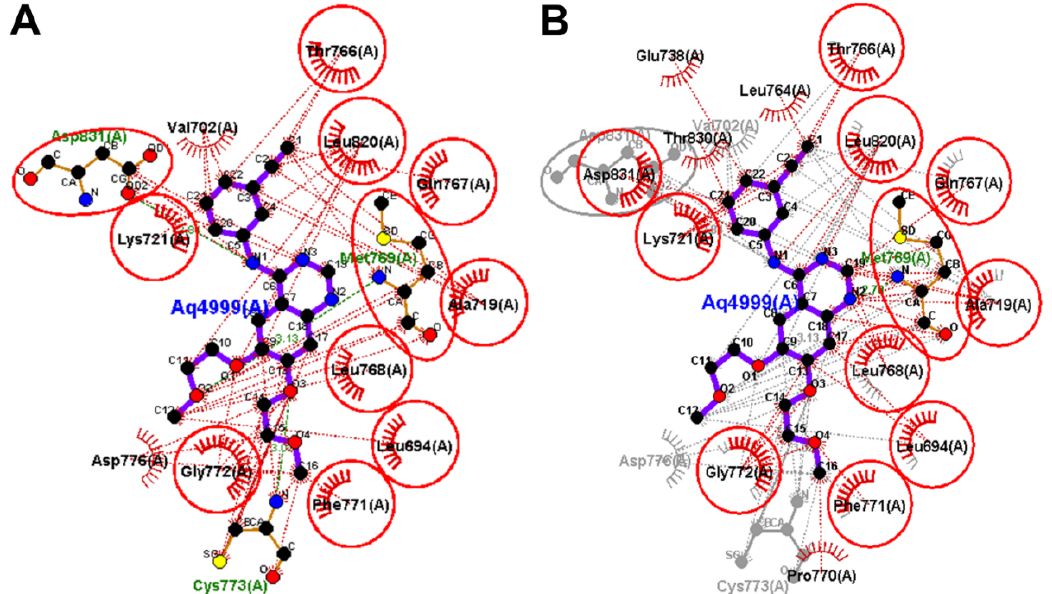
Figure 6. Binding interactions of erlotinib into EGFR (pdb: 1M17): ( A ) the redocked erlotinib; ( B ) superposed LigPlot view of the co-crystallized erlotinib (purple sticks), and the redocked erlotinib (gray sticks). The red circles/ ellipses show the equivalent binding interactions of the two molecules, hydrogen bond interactions are shown as olive green dotted lines and hydrophobic interactions are displayed in brick, red dotted lines.